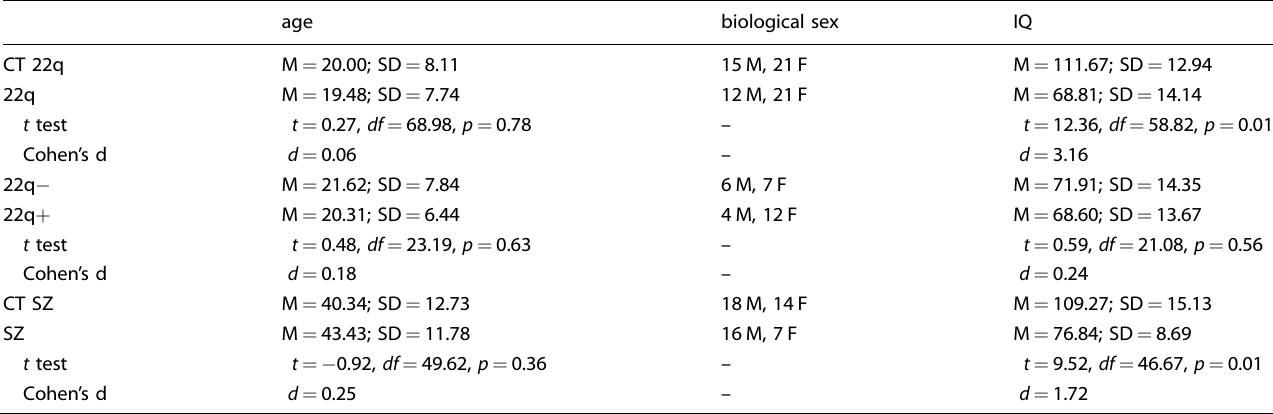
Table 1. Characterization of the controls, 22q11.2DS (overall and per sub-group: 22q − and 22q + ), and schizophrenia groups included in the analyses: age, biological sex, and